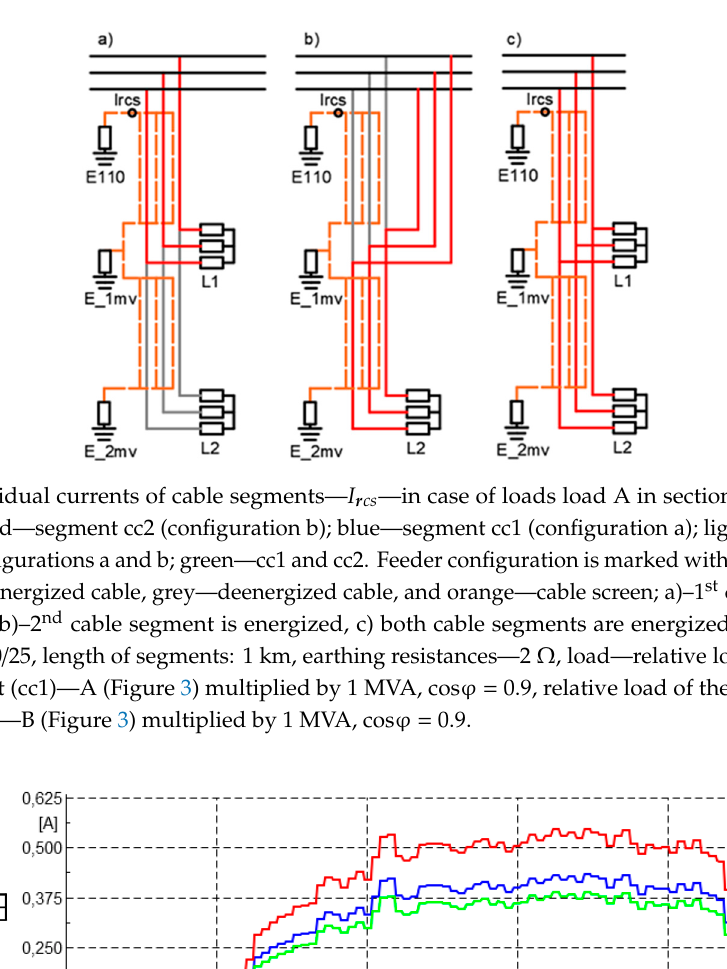
Figure 9. Residual currents of cable segments— I r cs —in case of loads load A in section cc1 and B in